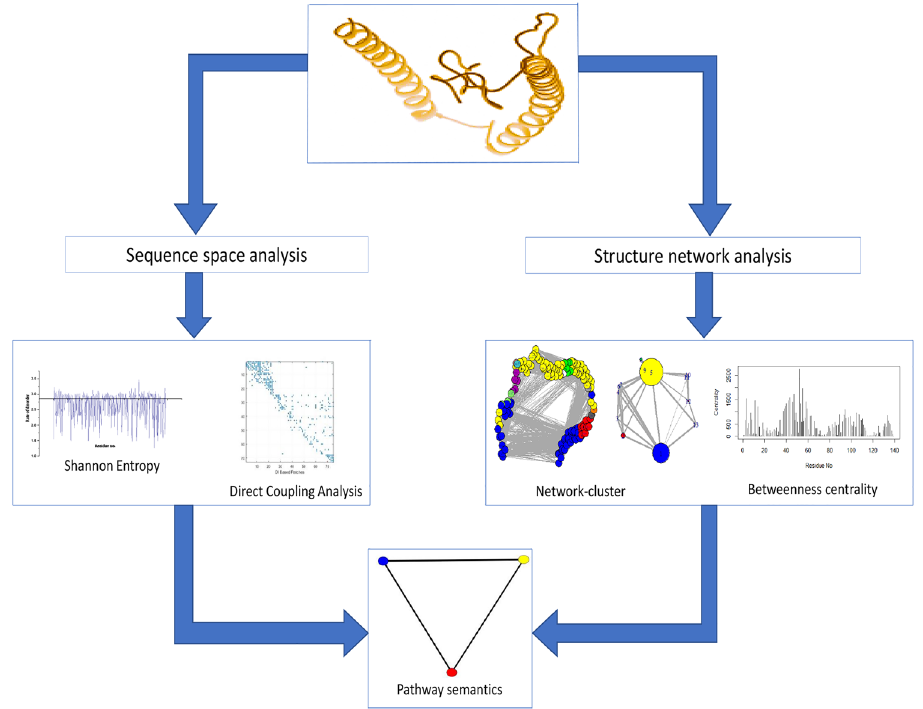
Figure 10. The flowchart of the proposed